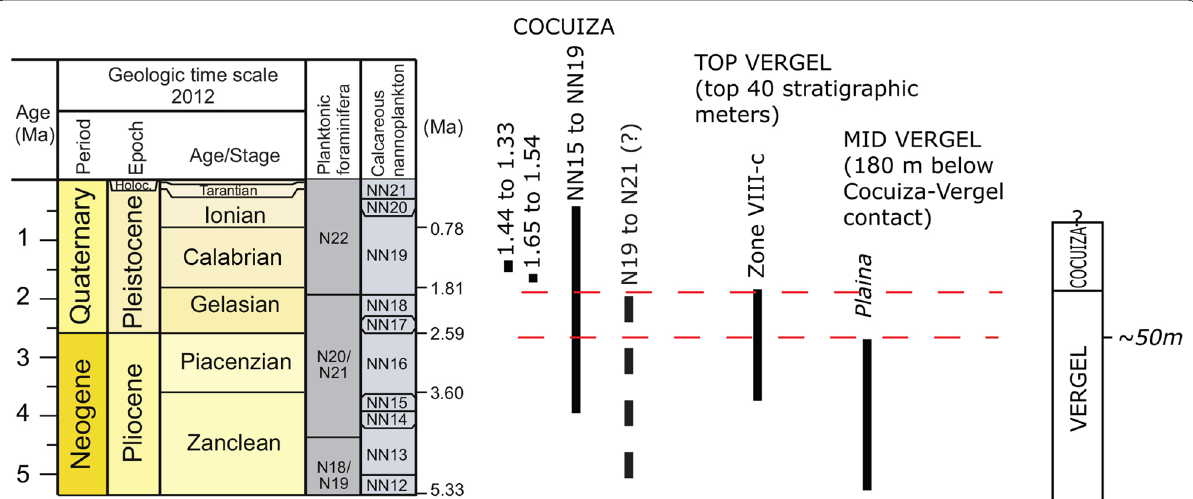
Fig. 30 New chronostratigraphy for the San Gregorio Formation. The age (Ma, million years ago) is derived from multiple palynological, nannoplankton, and foraminifera and 87 Sr/ 86 Sr analyses (see Additional files 3, 4,